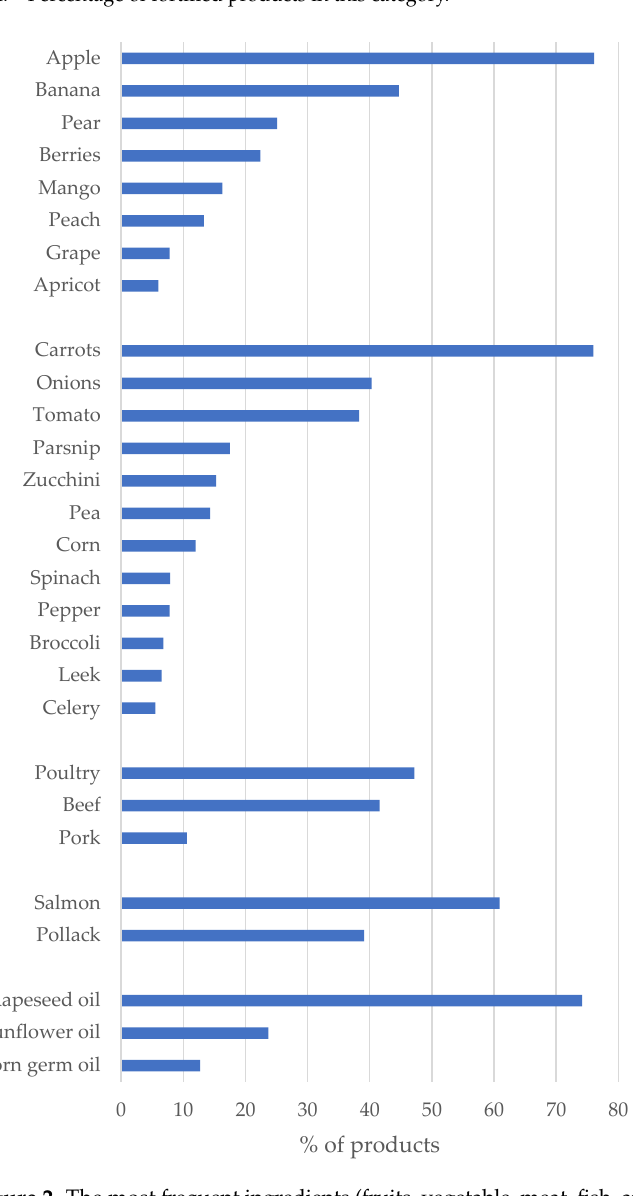
Figure 2. The most frequent ingredients (fruits, vegetable, meat, fish, and fat/oil, listed in at least ≥ 5% of products) in commercial complementary foods for infants and toddlers, results of a 2020 market survey in Germany (values are % of products containing fruits (i.e., fruit–cereal–meals, fruit products, fruit pouches, milk–cereal–meals in jars; n = 398), vegetables (i.e., menus, vegetables, and vegetable pouches; n = 308), meat (menus and meat products; n = 142), fish (fish menus and fish jars; n = 23), and added fat/oil (in menus and vegetable products; n = 283)).